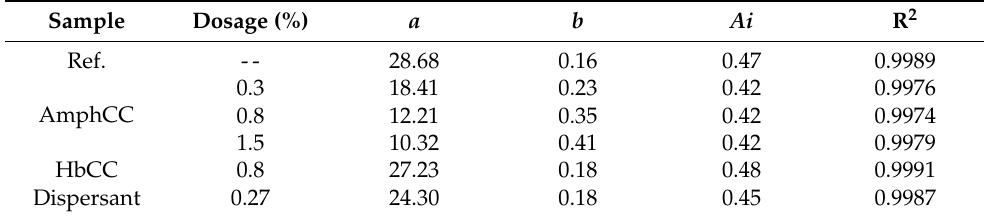
Table 3. Simulation results of water adsorption of mortar samples with the AmphCC addition.